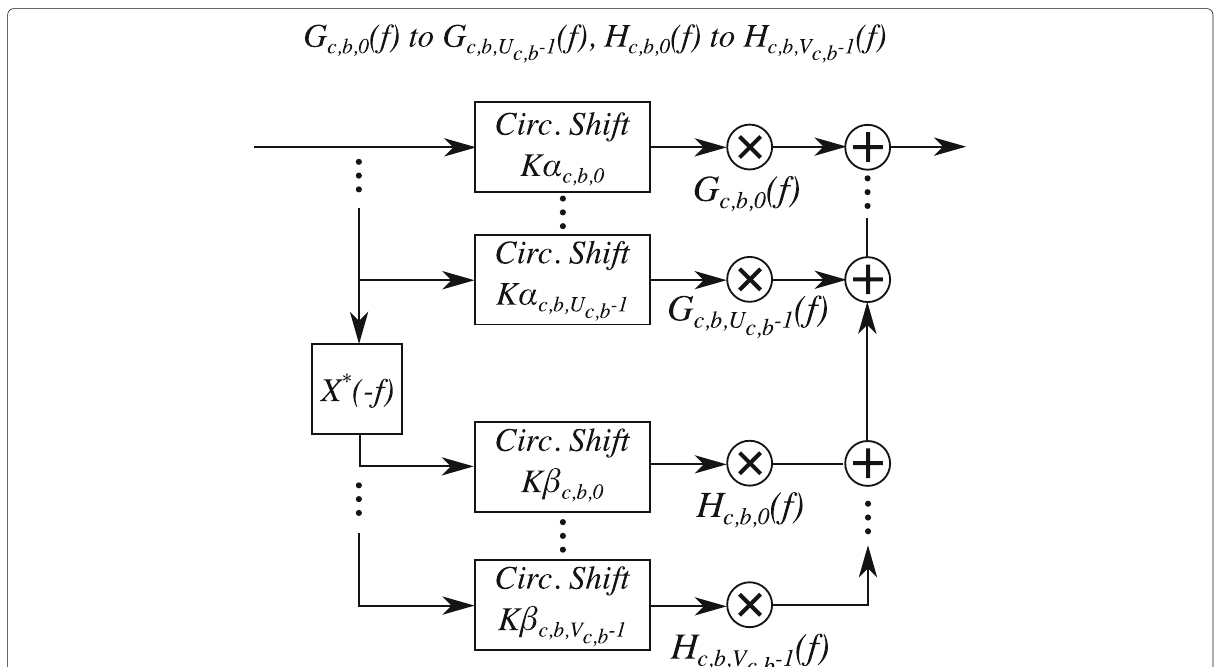
Fig. 5 Each sub-filter is a linear combination of a series of frequency domain filters and circular shifts, which implement the FSs